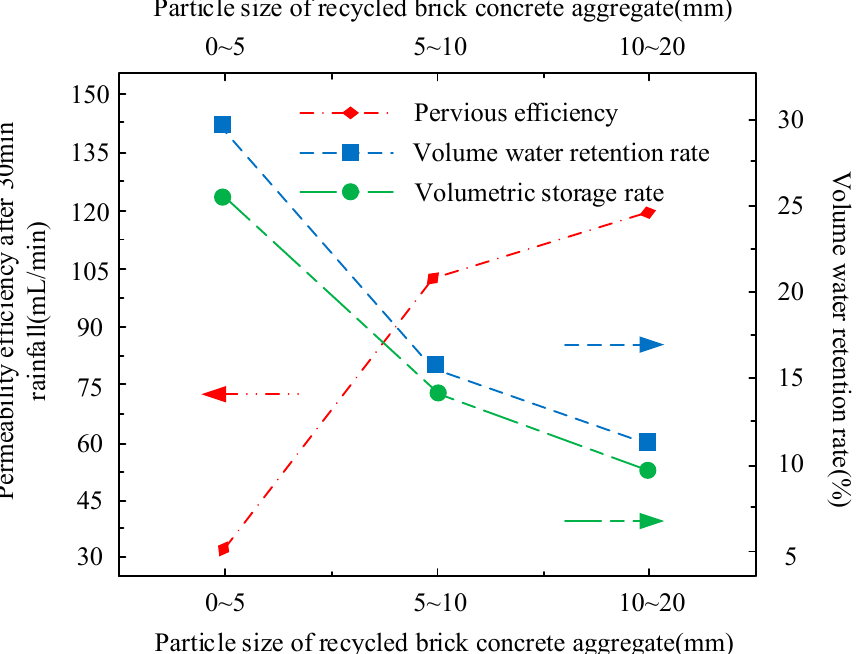
Figure 4. Influence of different gradation on permeability and storage performance of materials.